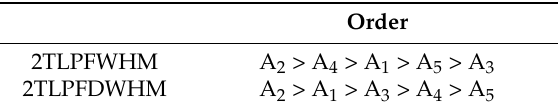
Table 7. Order of the green suppliers.